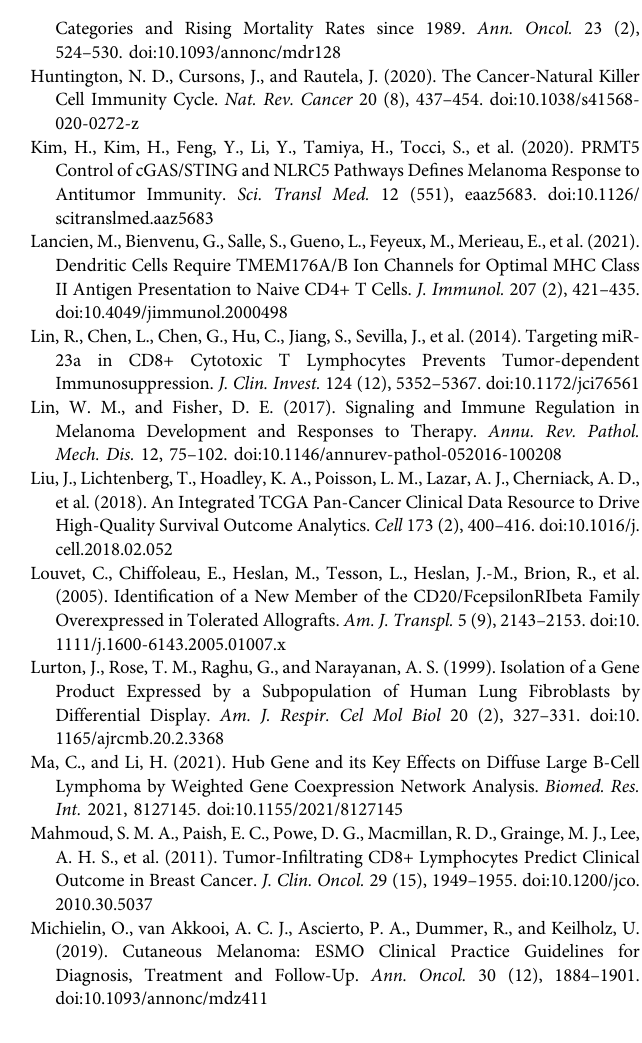
Supplementary Table 1 | Clinical characteristics of the SKCM patients based on TCGA. Supplementary Table 2 | The number of cases used in each cancer